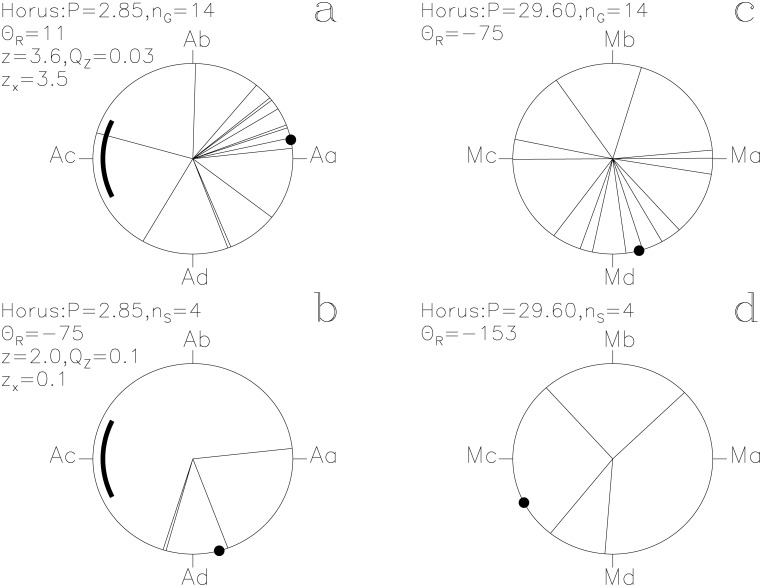
Horus.Time runs in the counter clock–wise direction on these unit circles. We give the z, Q
z and z
x values only when Q
z ≤ 0.2. The large black point indicates the ΘR direction. (a) g
i with Eq (11). Point Aa is at ϕ = 0 ≡ 0°. The thick line centered on point Ac at ϕ = 0.5 ≡ 180° outlines the proposed phase for the 10 hr eclipse of Algol. (b) s
i with Eq (11). (c) g
i with Eq (12). Point Ma at ϕ = 0 ≡ 0° is close to the proposed Full Moon phase. (d) s
i with Eq (12)